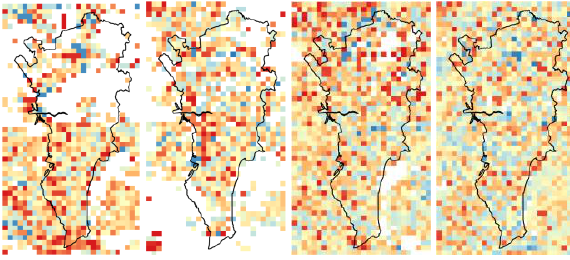
Figure 14. Sample PM 2.5 estimation maps using the best wet model for July 2017 to 2020.